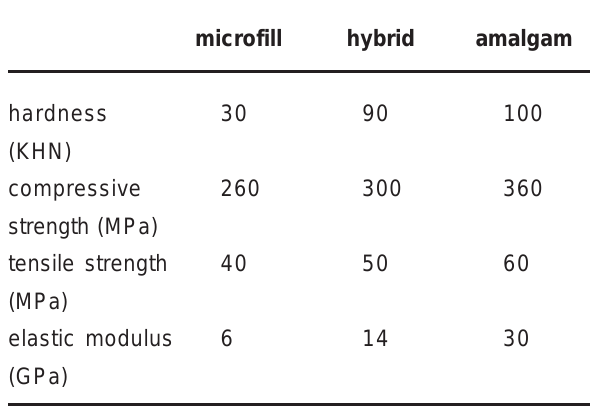
TABLE 2- Some mechanical properties of a lathe-cut amalgam compared with resin-based composites (McCabe JF 12